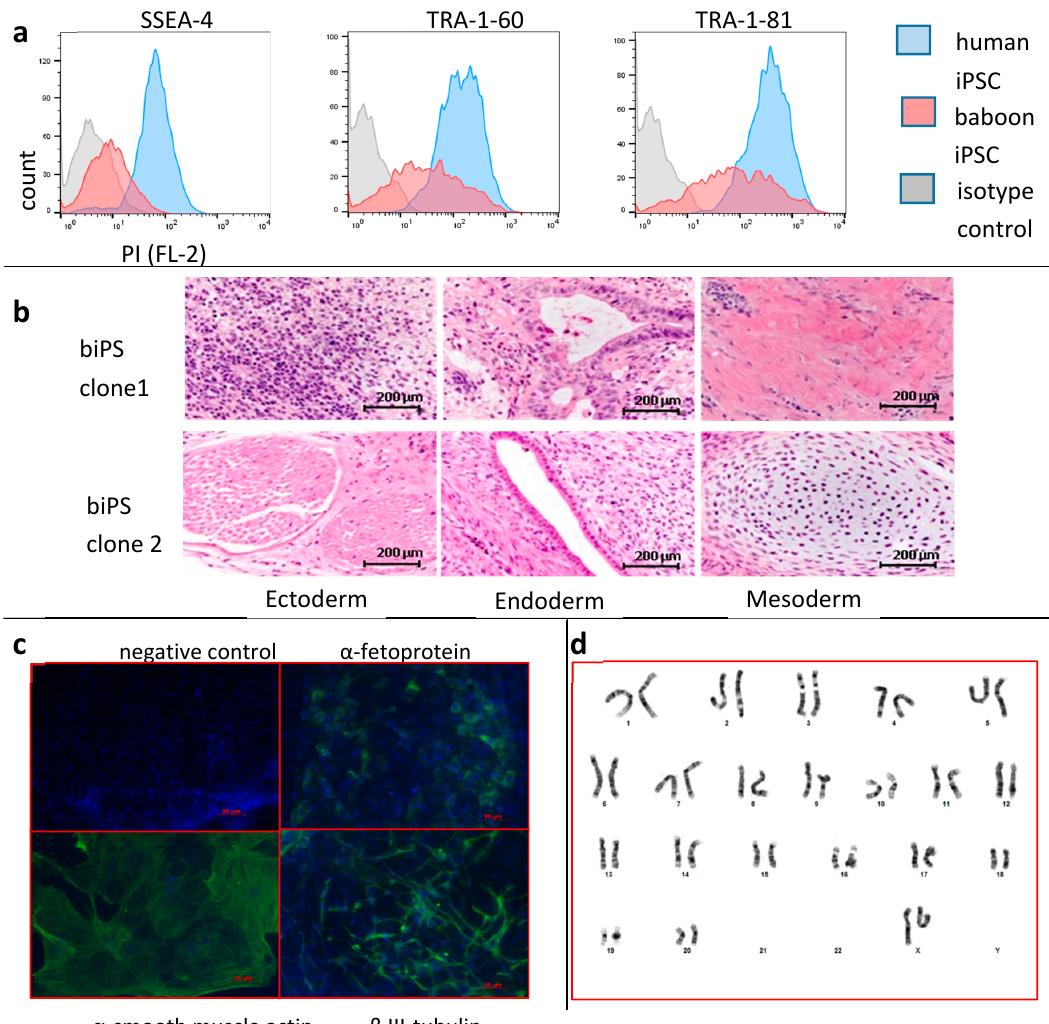
Figure 1. Production of baboon iPSCs: ( a ) FACS analysis of human and baboon iPSCs grown in